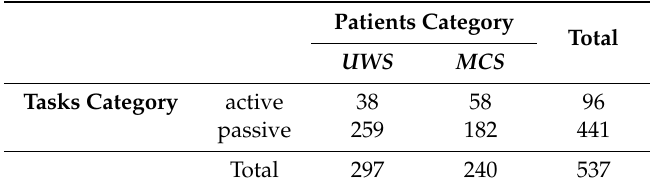
Table 3. Distribution of the activation peaks. Here we report the patient-by-task category contingency table and the resulting test statistic (chi-squared